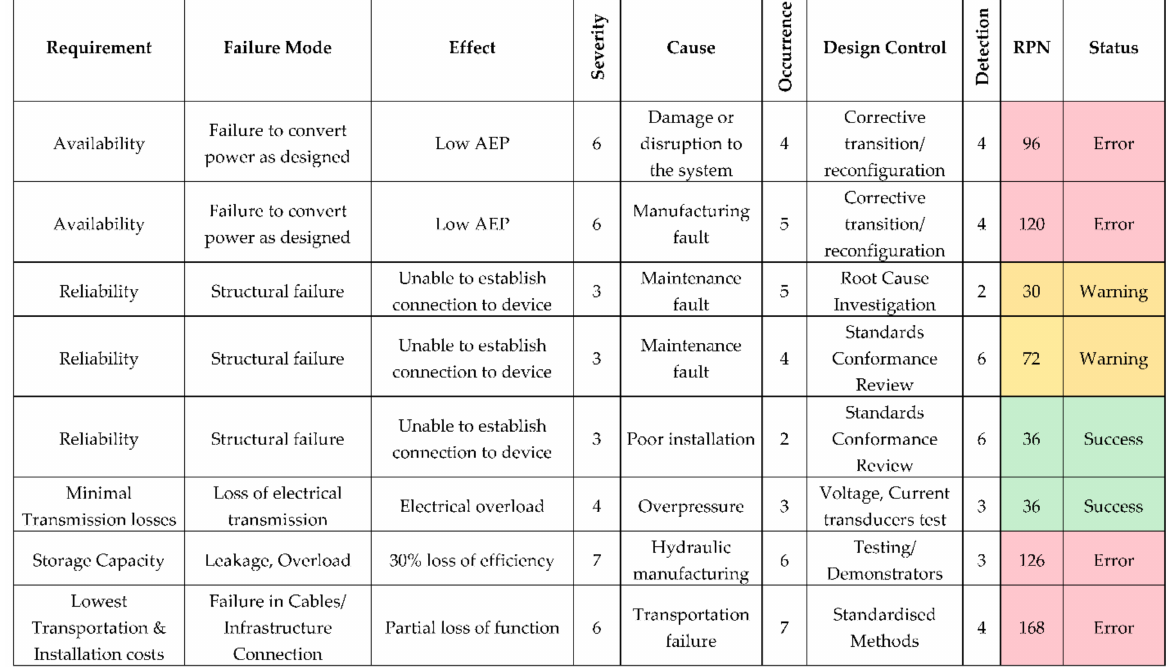
Figure 6. Example of FMEA analysis output highlighting where RPN and occurrence limits have been exceeded (legend: red (error) for RPN > 72, amber (warning) for occurrence > 4 and/or RPN = 72, green (success) for RPN and occurrence < threshold).